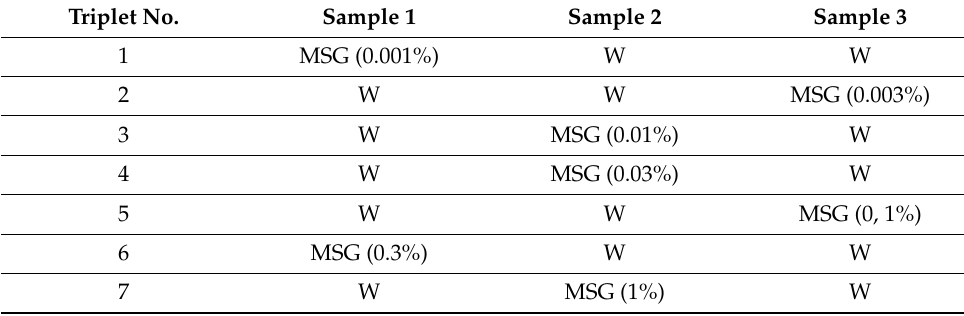
Table 1. Concentrations and locations of MSG samples in individual